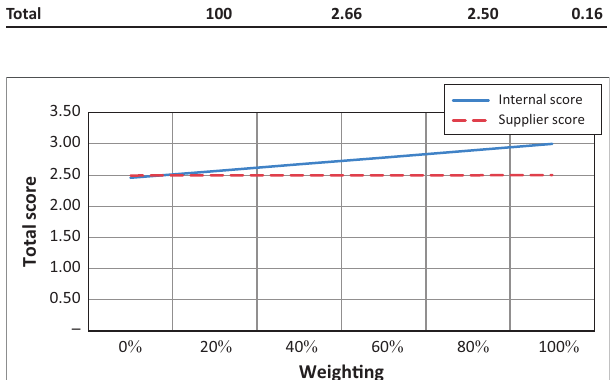
FIGURE 1: Costs area sensitivity.